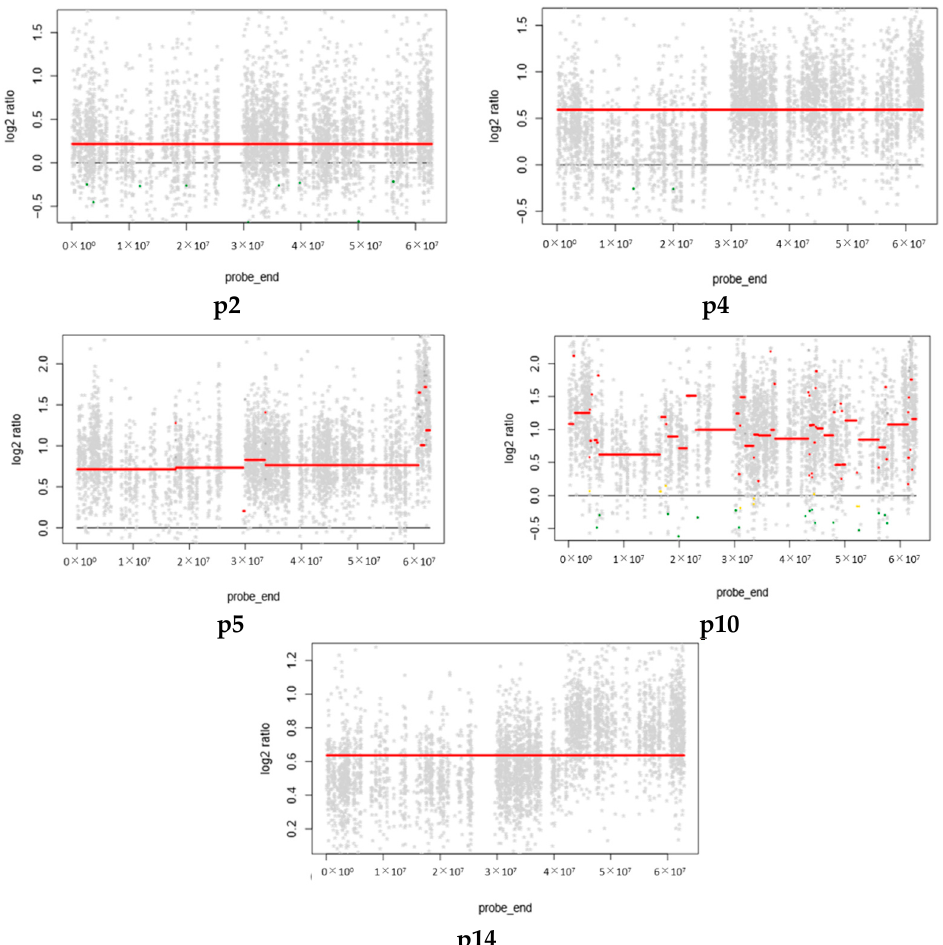
Figure 4. The gain of copy number variation (CNV) at chromosome 20. Patients p4, p5, p10, and p14 showed the gain of chromosome 20, beside patient p2, who did not pass the criteria .